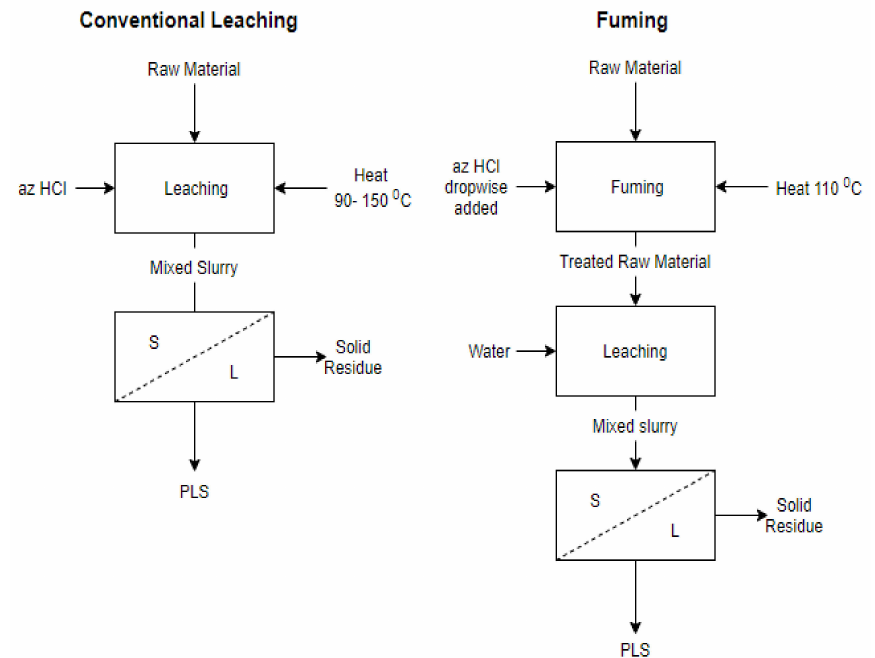
Figure 1. Flowsheet of conventional leaching and fuming tested in this work.